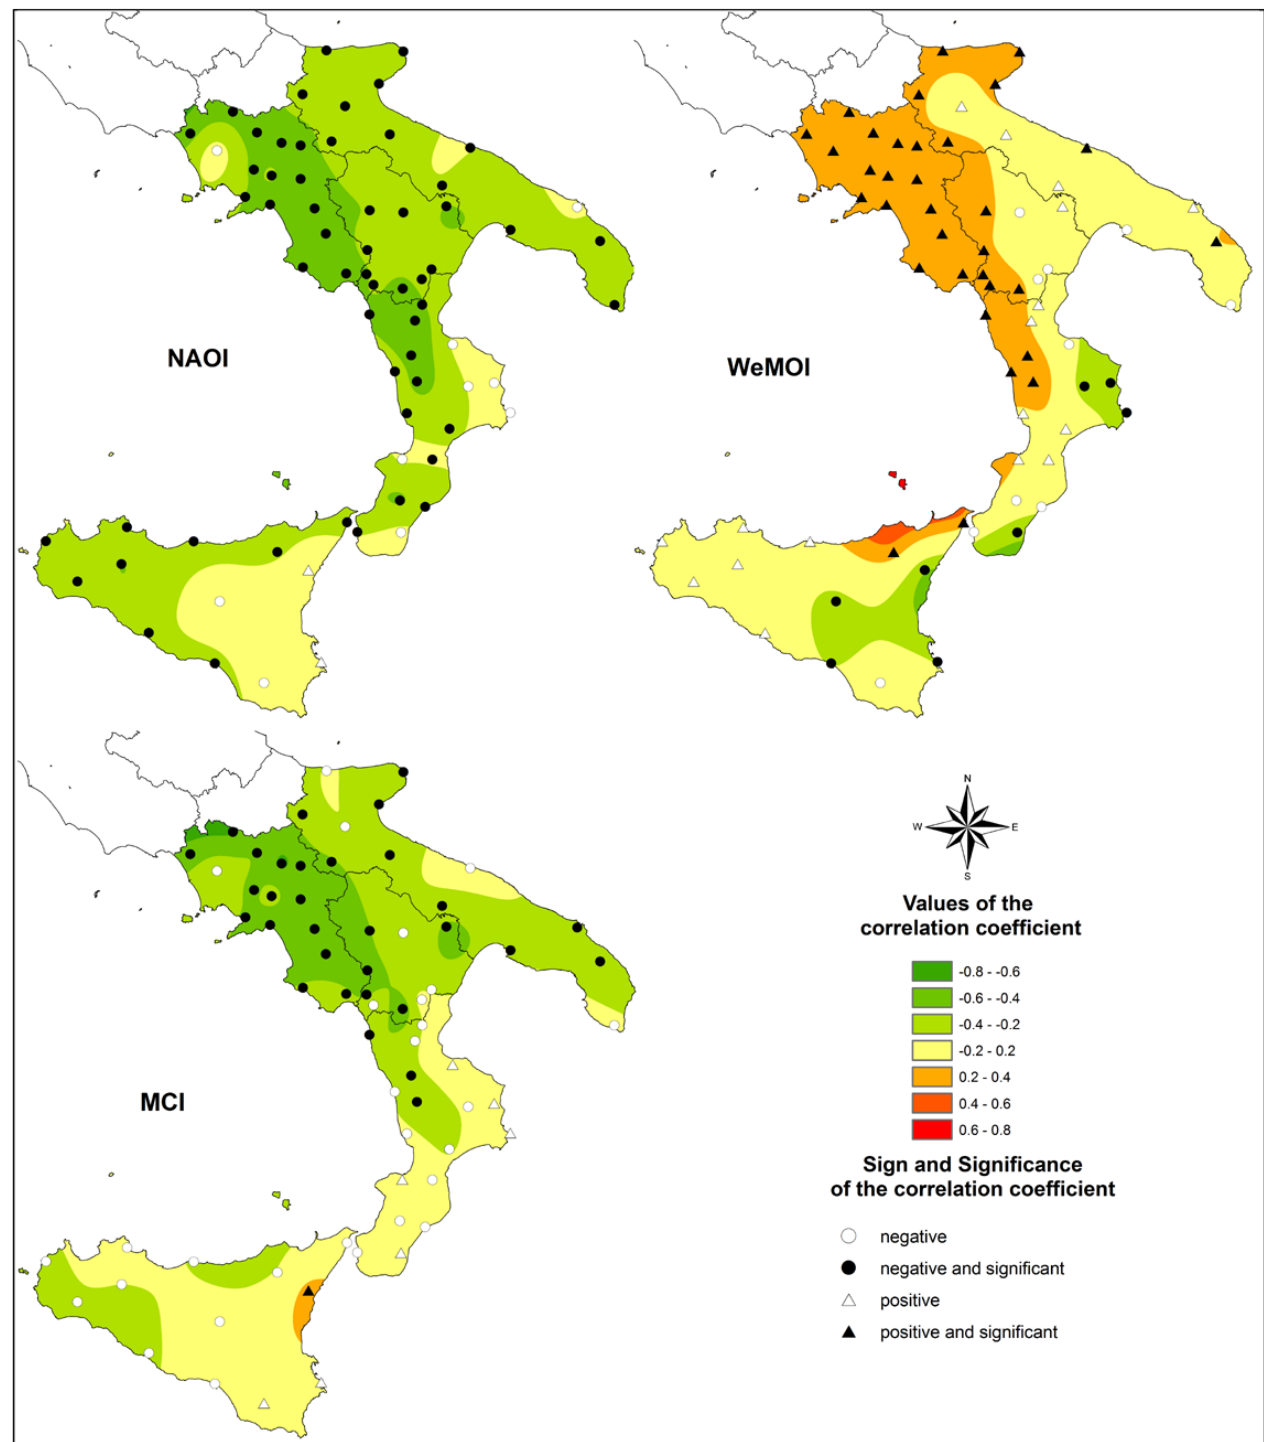
Fig. 7. Maps of Spearman’s rank correlation coefficient between winter precipitation and the climatic indexes. For each rain gauge, the sign and the significance of the correlation coefficient are evidenced through different